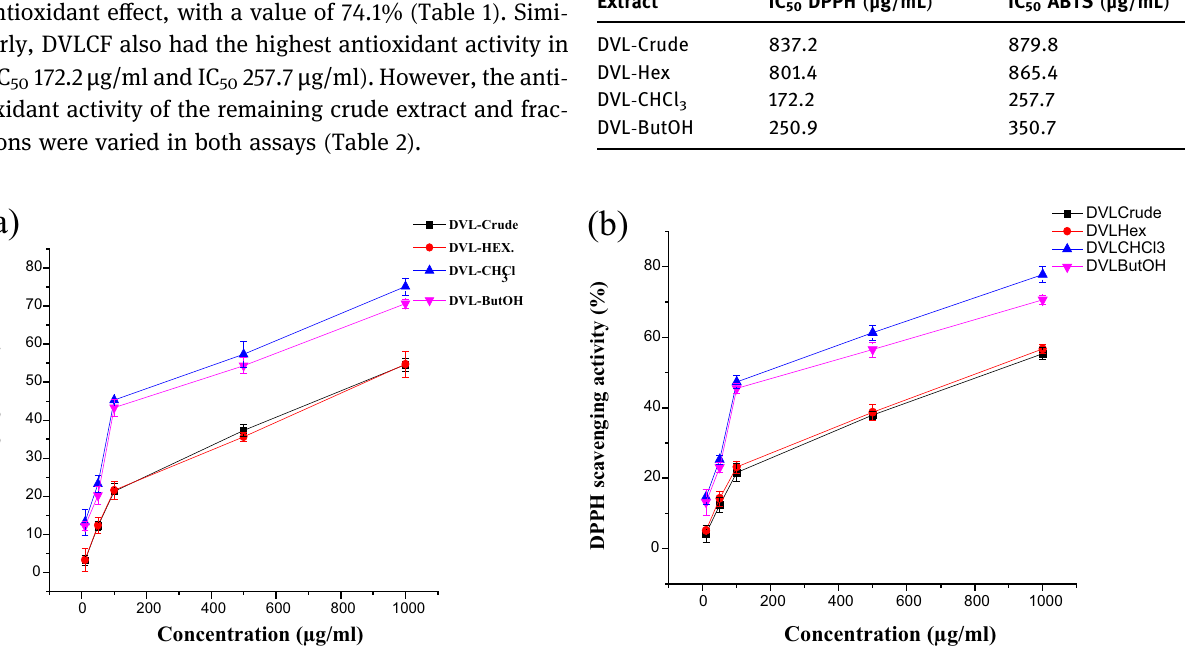
Figure 2: Sacavenging activity for ( a ) DPPH and ( b ) ABTS. Results are presented as mean ± standard deviation ( SD ) .